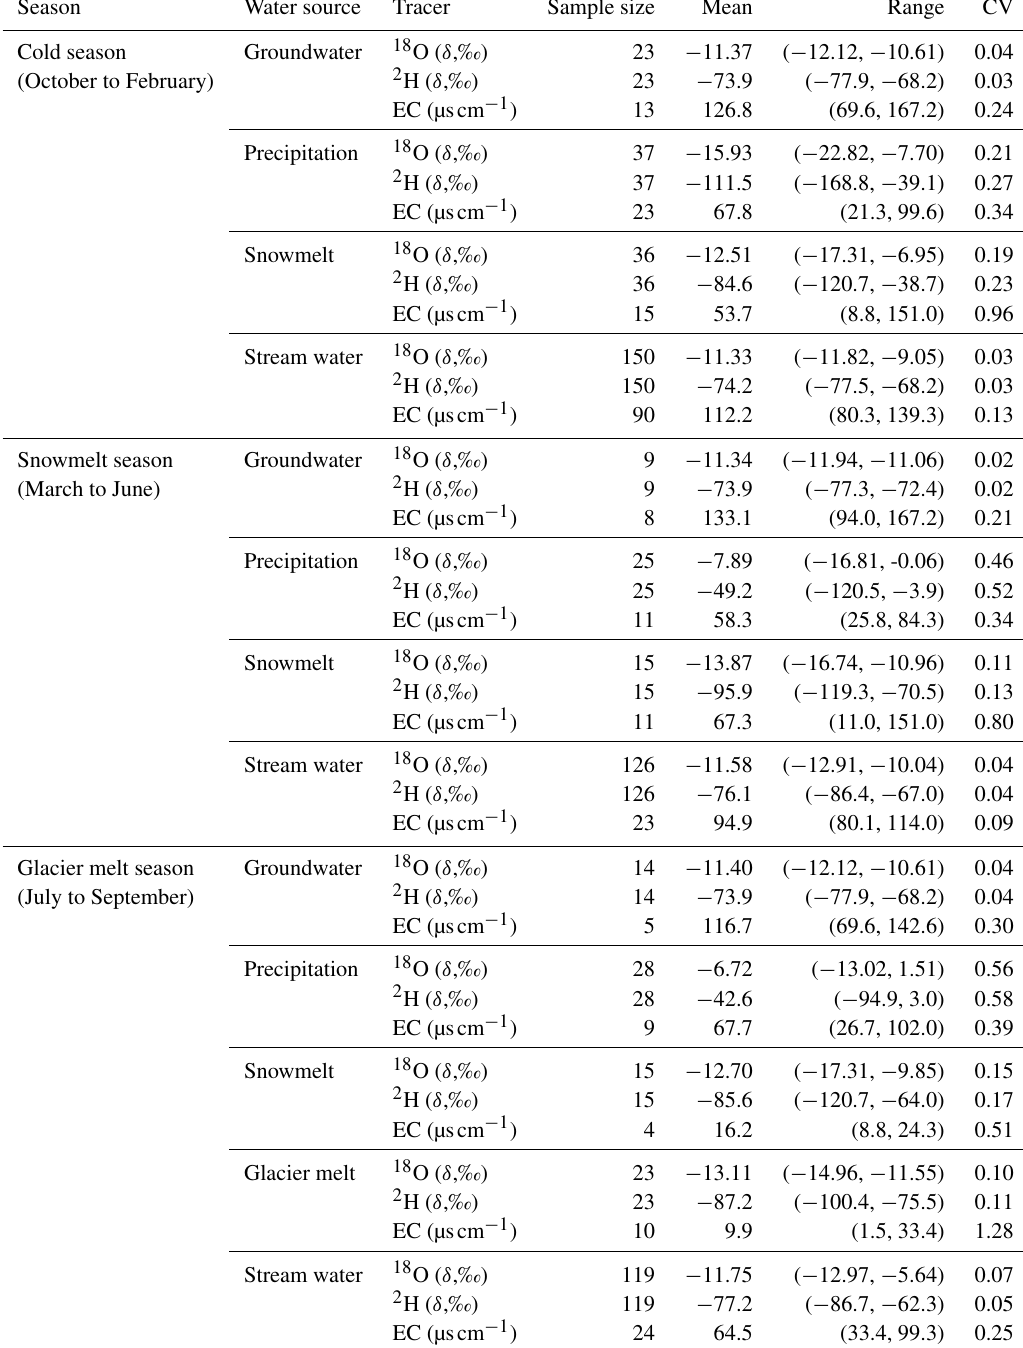
Table 1. Tracer signatures measured from water samples in three